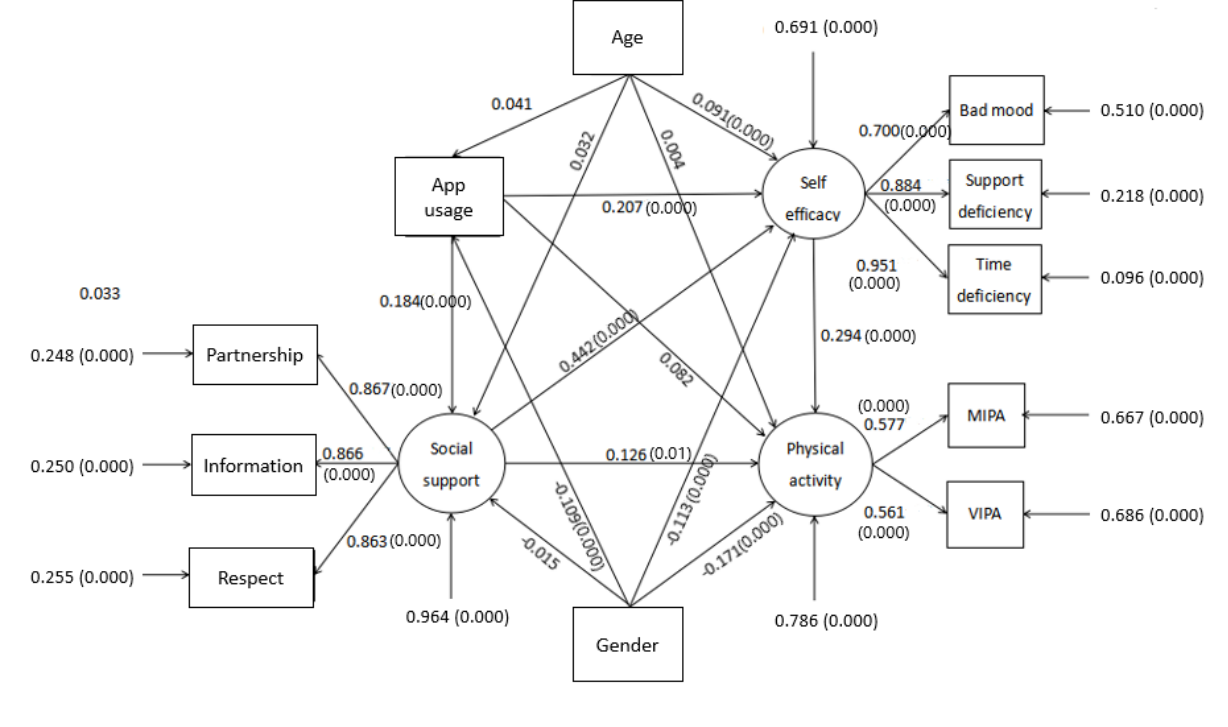
Figure 4. Multi serial mediation model containing age and sex. Age is a continuous co-variable; gender is described as a two-level categorical variable where male=1 and female=2. Social support is described by three manifest indicators (partnership support, information support, and respect support). Self-efficacy is described by bad mood, support deficiency, and time deficiency; VIPA is vigorous-intensity physical activity and MIPA is moderate-intensity physical activity. (0.000) represents significant path coefficients at the .001 level and (0.01), at the .05